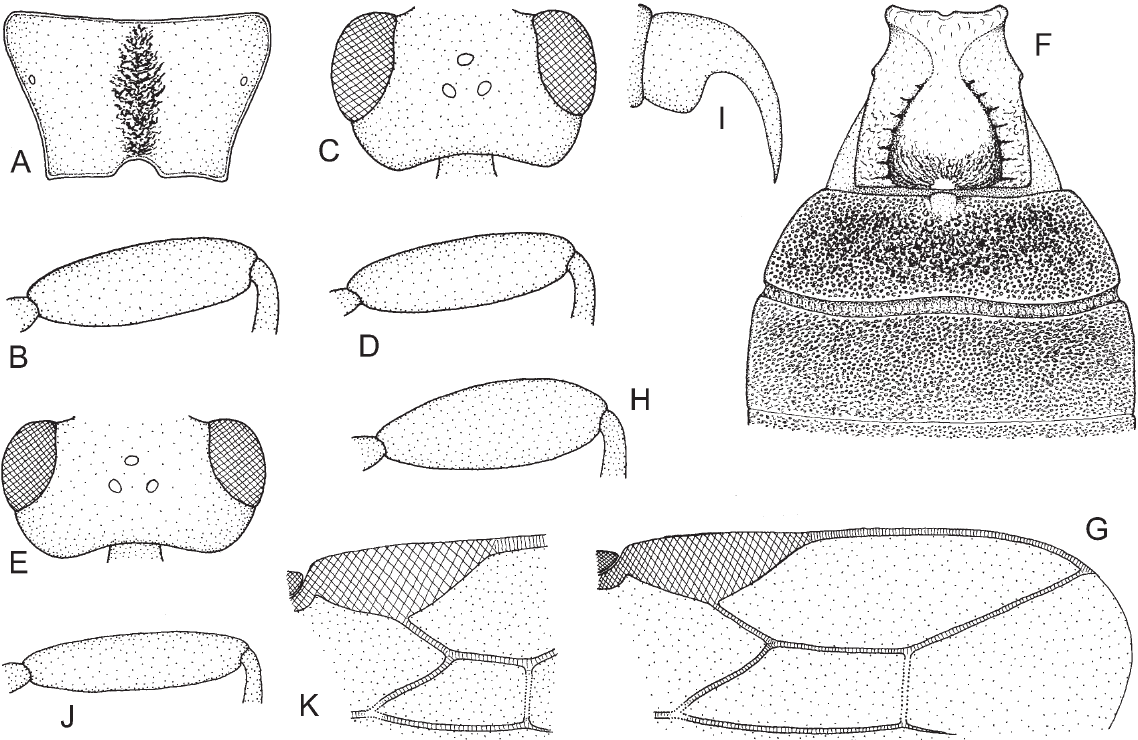
Fig. 19. — A-D . Bracon ( Bracon ) longicollis Wesmael, 1838 (A: ♀ / ♂ paralectotype, B: ♀ paralectotype, C -D: ♂ paralectotype). A . Propodeum. B . Hind femur. C . Head in dorsal view. D . Hind femur. — E-I . Bracon ( Bracon ) gusaricus Telenga, 1933, ♀. E . Head in dorsal view. F . Tergites 1-3. G . Distal part of right forewing. H . Hind femur. I . Claw. — J-K . Bracon ( Bracon ) variegator Spinola, 1808, ♀ / ♂. J . Hind femur. K . Middle part of right